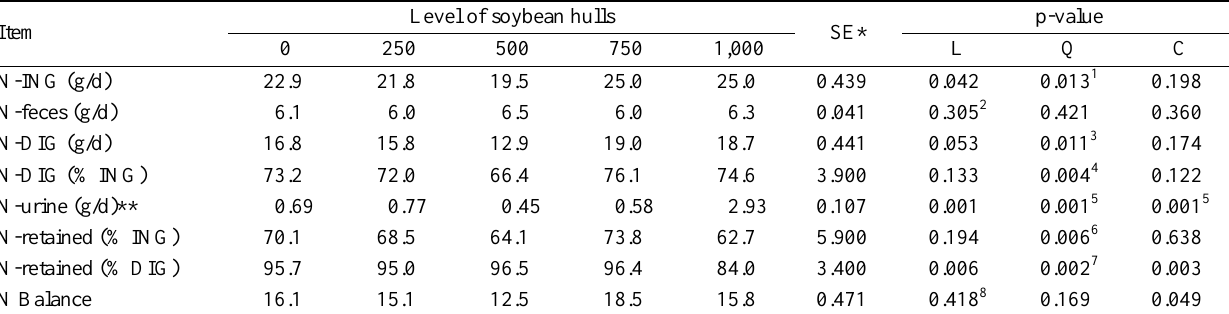
Table 5. Ingestion of nitrogen (N-ING), excretion of nitrogen in feces (N-feces), digested or absorbed nitrogen (N-DIG) and retained nitrogen (N-retained) in lambs fed diets containing different levels of soybean hulls as a substitute for corn